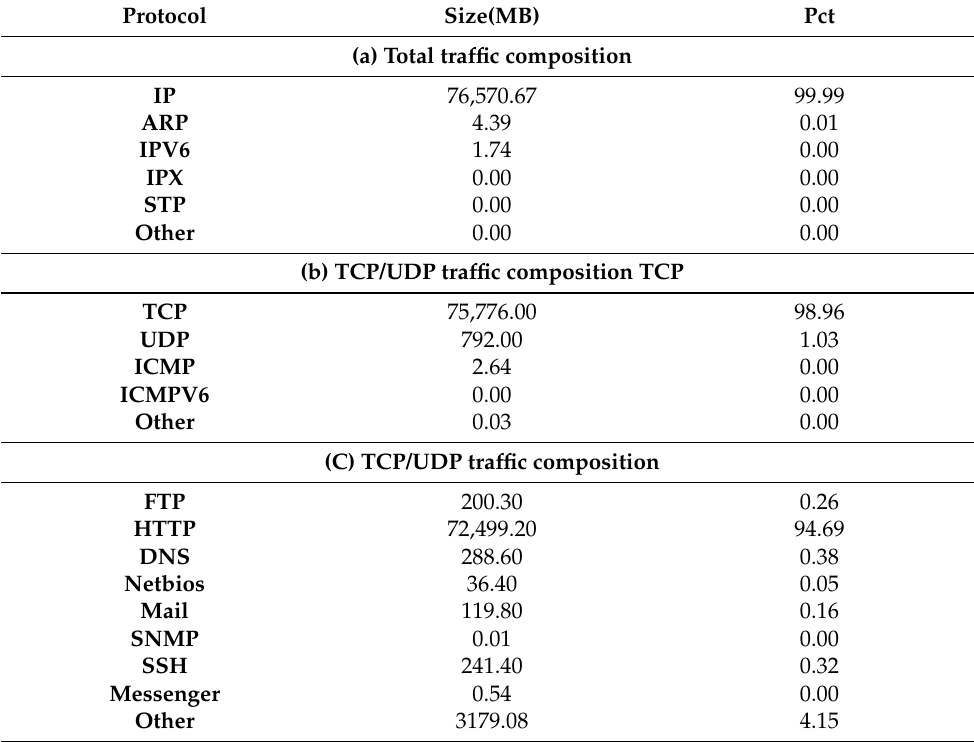
Table 4. Traffic composition in the ISCX data